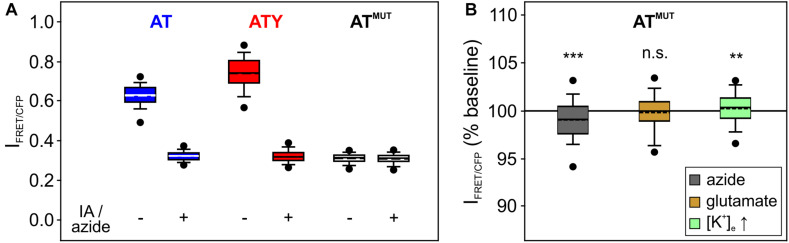
Control experiments using the ATP-binding deficient AT1.03R122K/R126K. (A) The signal of the ATP sensor AT and ATY during inhibition of ATP synthesis approaches the signal of AT1.03R122K/R126K (ATMUT). Shown is the non-normalized intensity ratio I = IFRET/ICFP to allow for comparison between AT, ATY, and ATMUT in the absence or presence of IA + azide. The following number of cells was included in the analysis (from left to right): 381; 381; 400; 400; 810; 810 (each from N = 9 experiments). (B) The signal of ATMUT is only marginally affected by application of azide, glutamate or increases in [K+]e. ***p < 0.001; **p < 0.01; and n.s. p > 0.05 compared to baseline, paired t-test. n = 285, 260, and 265 cells from 3 experiments each for azide, glutamate and high [K+], respectively.